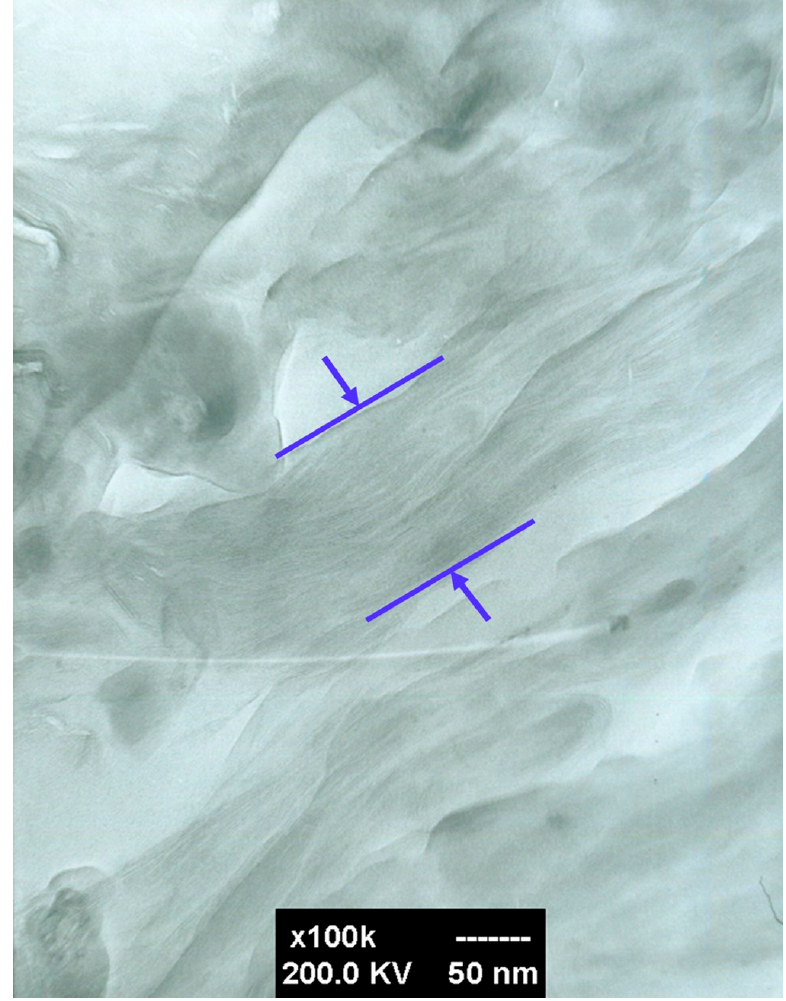
Figure 5. The TEM of PLLA-PEG1000/1.0% o-MMT nanocomposites (magnification: ×100,000). The blue marking shows an intercalated structure and a silicate layer of o-MMT with a thickness of about 100 nm.